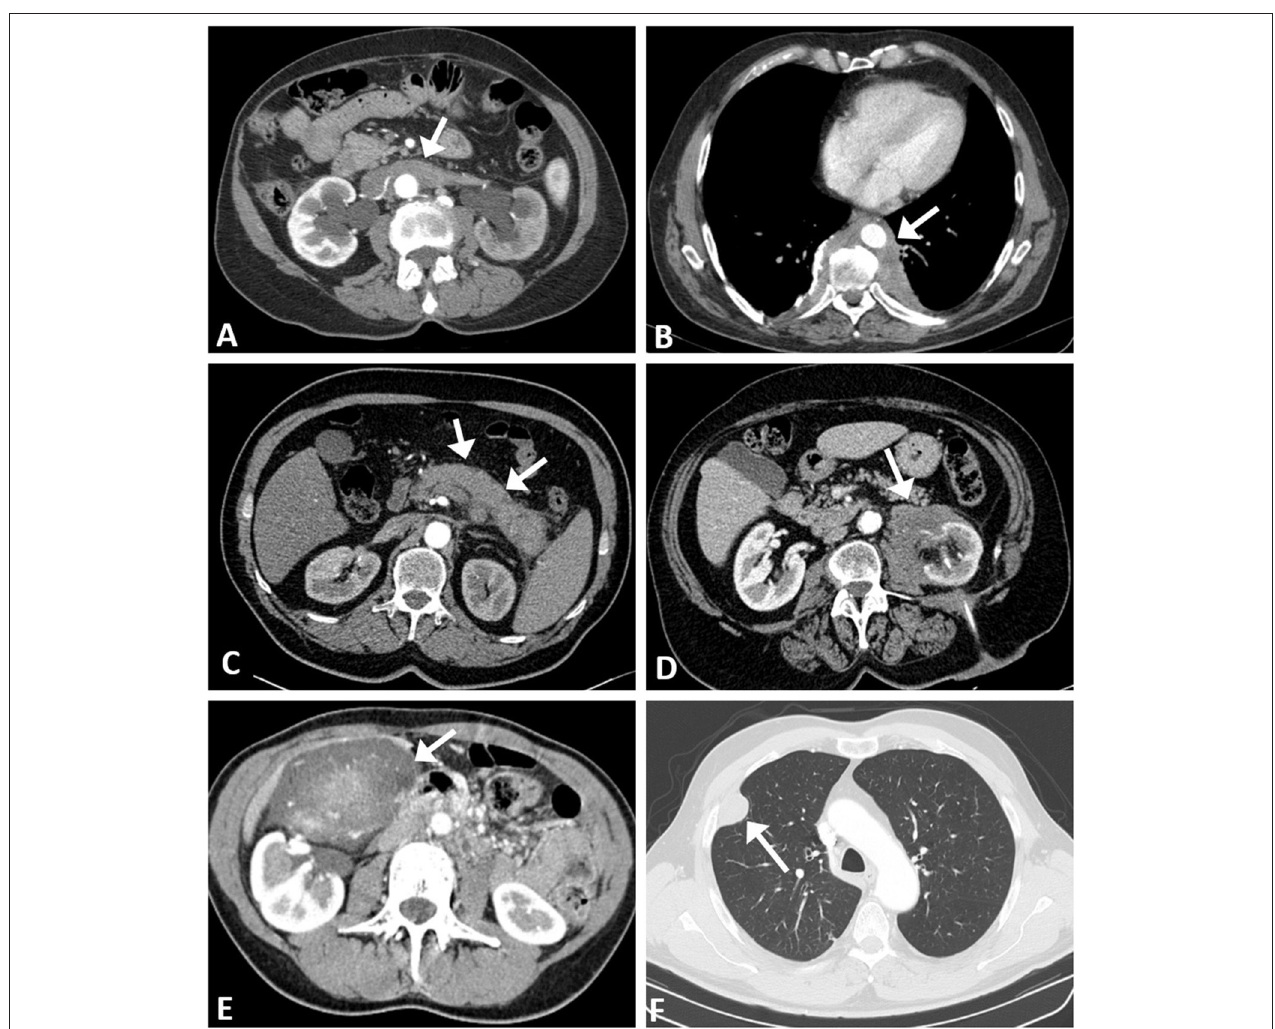
FIGURE 2 | CT Imaging overview of chronic periaortitis and extra-retroperitoneal lesions. (A) Sleeve thickening of the abdominal aorta ( arrow ) with involvement of the renal arteries; the fibro-inflammatory tissue wraps around the excretory system and determines bilateral hydronephrosis. (B) Typical aspect of “coated aorta” involvement along the descending thoracic tract: the inflammatory tissue ( arrow ) also expands into the paravertebral space and envelops the verterbal bodies. (C) IgG4-related chronic pancreatitis: the normal glandular structure is subverted ( arrows ) and a pseudonodular lesion is evident at the level of the pancreatic tail. (D) Atypical localization of retroperitoneal fibrosis: the pathological tissue encroaches into the left perirenal space ( arrow ) without involvement of excretory system. (E) Unusual gallbladder localization of IgG4-related disease: a bulky mass ( arrow ) attached to the bottom of the gallbladder with large cholecystic feeding vessels. (F) Thoracic localization: a pseudonodular lesion arises from the right pleural sheet ( arrow ). group (log-rank test p = 0.54) ( Figure 4 ). The presence of